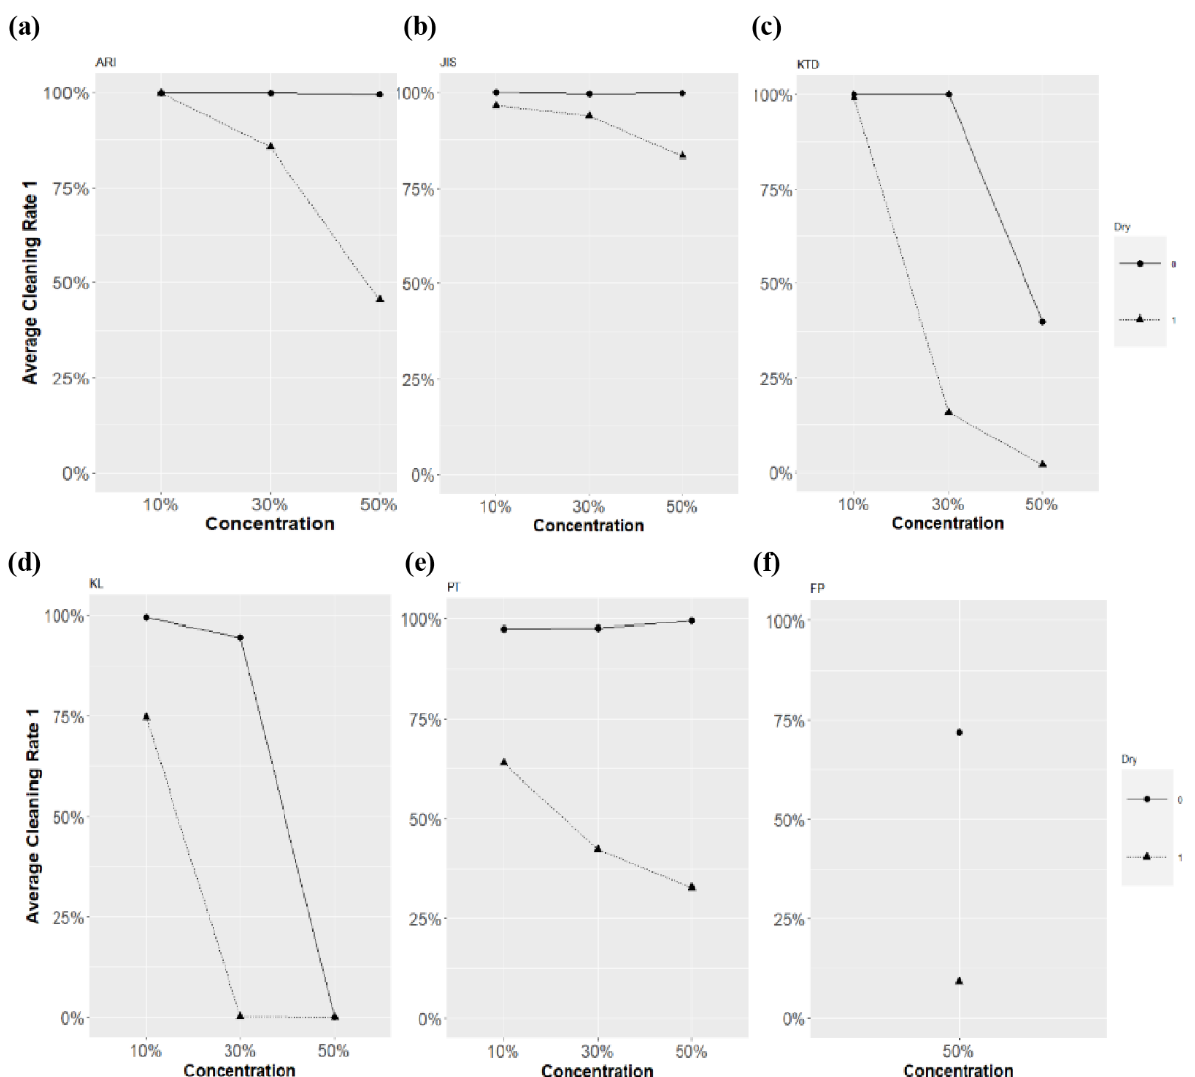
Figure 23. Comparison of dry and non-dry characteristics of blockages ( a ) ARI, ( b ) JIS, ( c ) KTD, ( d ) KL, ( e ) PT, ( f ) FP.